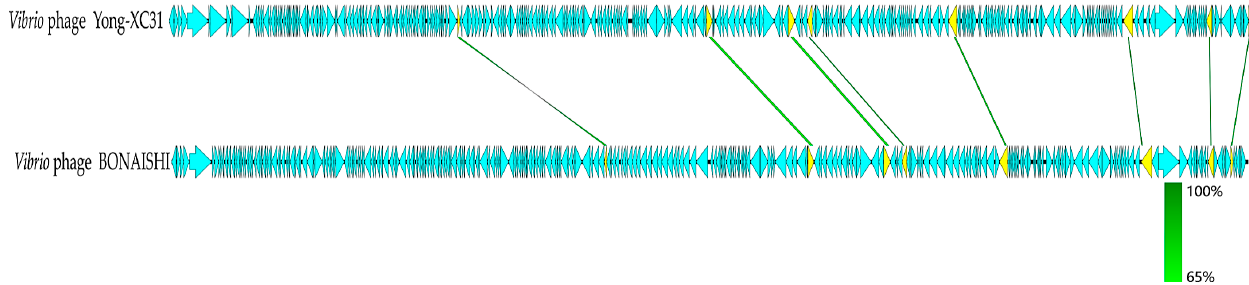
Figure 7. Genome comparison of Vibrio phage Yong-XC31 and the most closely related phage BONAISHI. Strain-specific protein coding genes are shown in light blue, protein coding genes conserved in Yong-XC31 and Vibrio phage BONAISHI are shown in